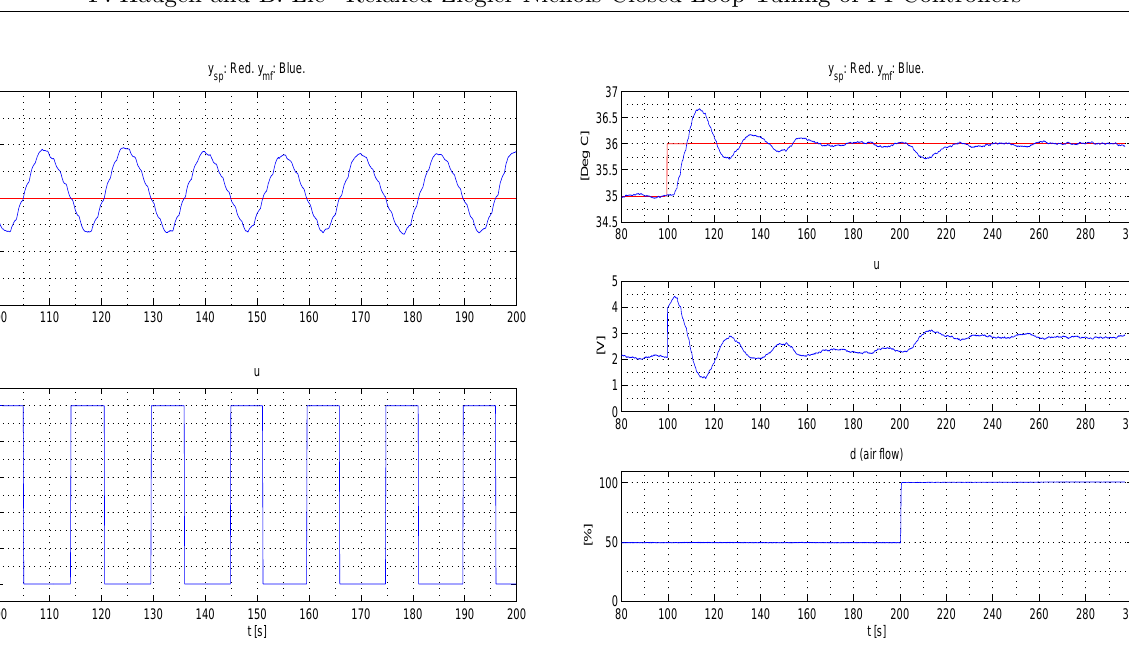
Figure 8: Responses during relay tuning Performance and stability robustness measures are calculated from the time-series as explained in Sec- tion 3.2.